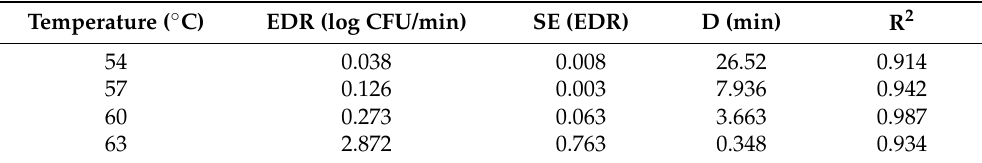
Table 1. Mean and standard error (SE) of the exponential death rate (k), D values and coefficient of determination (R 2 ) of the log-linear primary models fitted to thermal inactivation curves of S. Typhimurium in alheira batter.